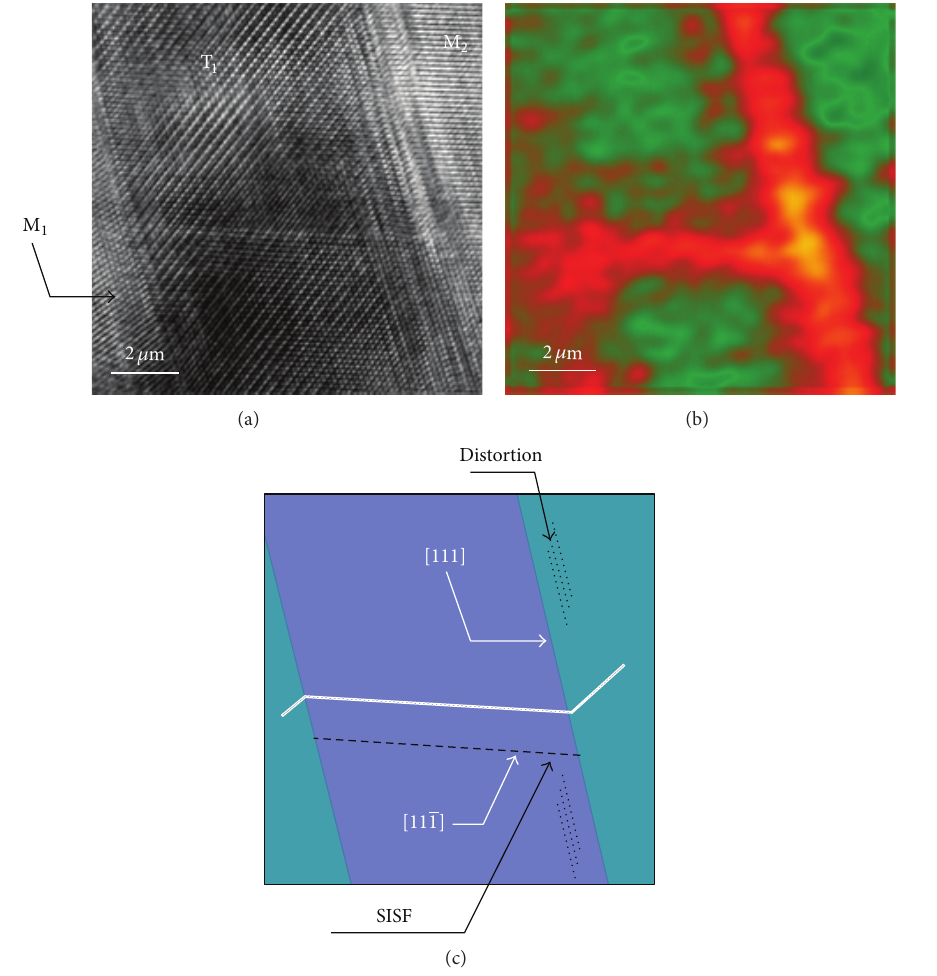
Figure 2: (a) A local HRTEM graph of the continuous 𝛾 laths. (b) A HAADF-STEM graph of the same region. (c) A schematic illustration of this